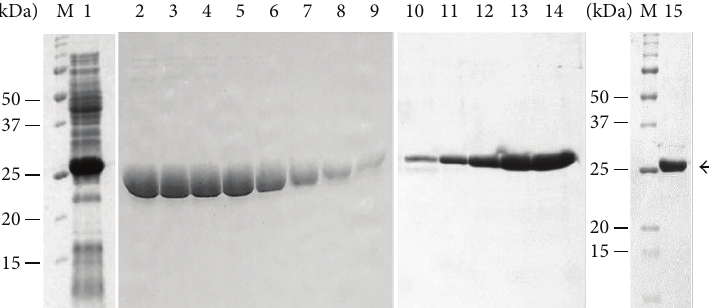
Figure 2: Purification of TvoOgg recombinant protein from E. coli . A Coomassie brilliant blue stained SDS-polyacrylamide gel (15%) showing separationofalysateofBL21(DE3)cellscontainingpET28a-TvoOggafterinductionby1 mMIPTGfor5 hr(lane1),elutedfractionsofTvoOgg from Ni-NTA agarose columns (lane 2–9), or SP Sepharose FF columns (lane 10–14), respectively, and TvoOgg protein after dialysis against dialysis buffer 1 (lane 15). The TvoOgg protein is indicated by an arrow. Lane M contained molecular mass standards (Bio-Rad, U.S.A.) as indicated on the